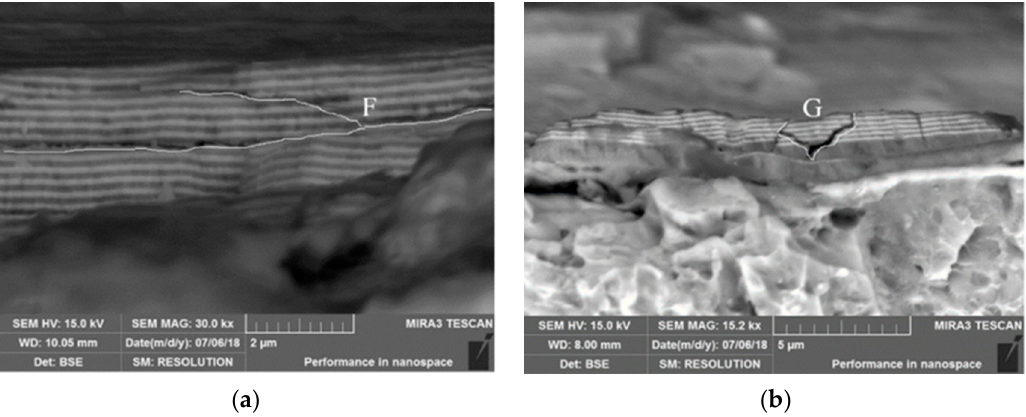
Figure 13. Development of a crack in 10 μ m thick TiN/ZrN multilayer coating deposited on Ti-6Al-4V alloy using PVD equipment (Pro China Limited AS700DTX, Beijing, China); ( a ) deflection of a crack (marked by letter F), ( b ) branching of a crack (marked by letter G), reprinted from Coatings , Reference [111], published in MDPI.